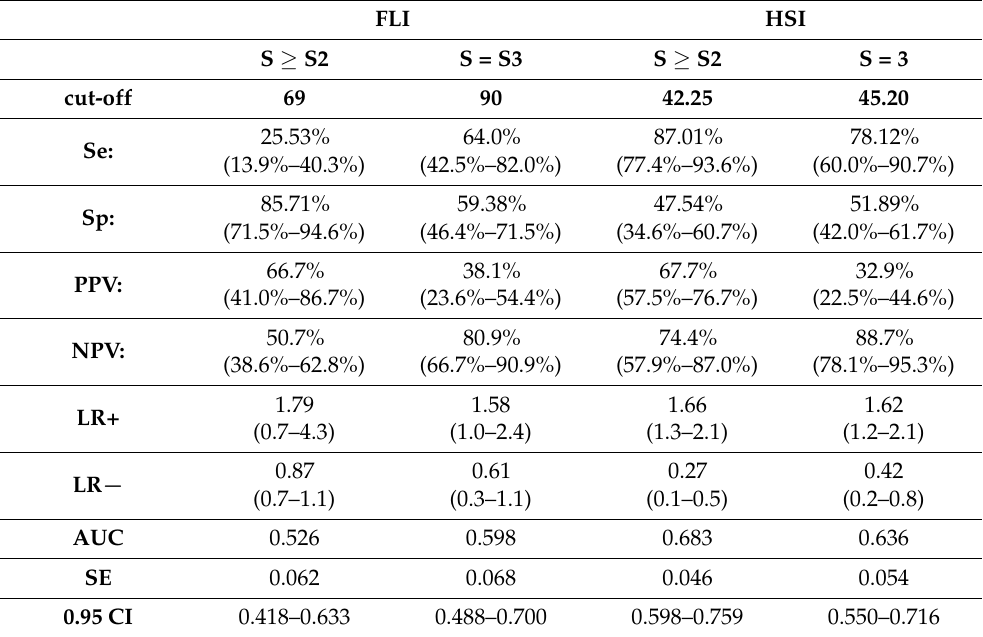
Table 2. The diagnostic accuracy of fatty liver index (FLI) and hepatic steatosis index (HSI) in the detection of